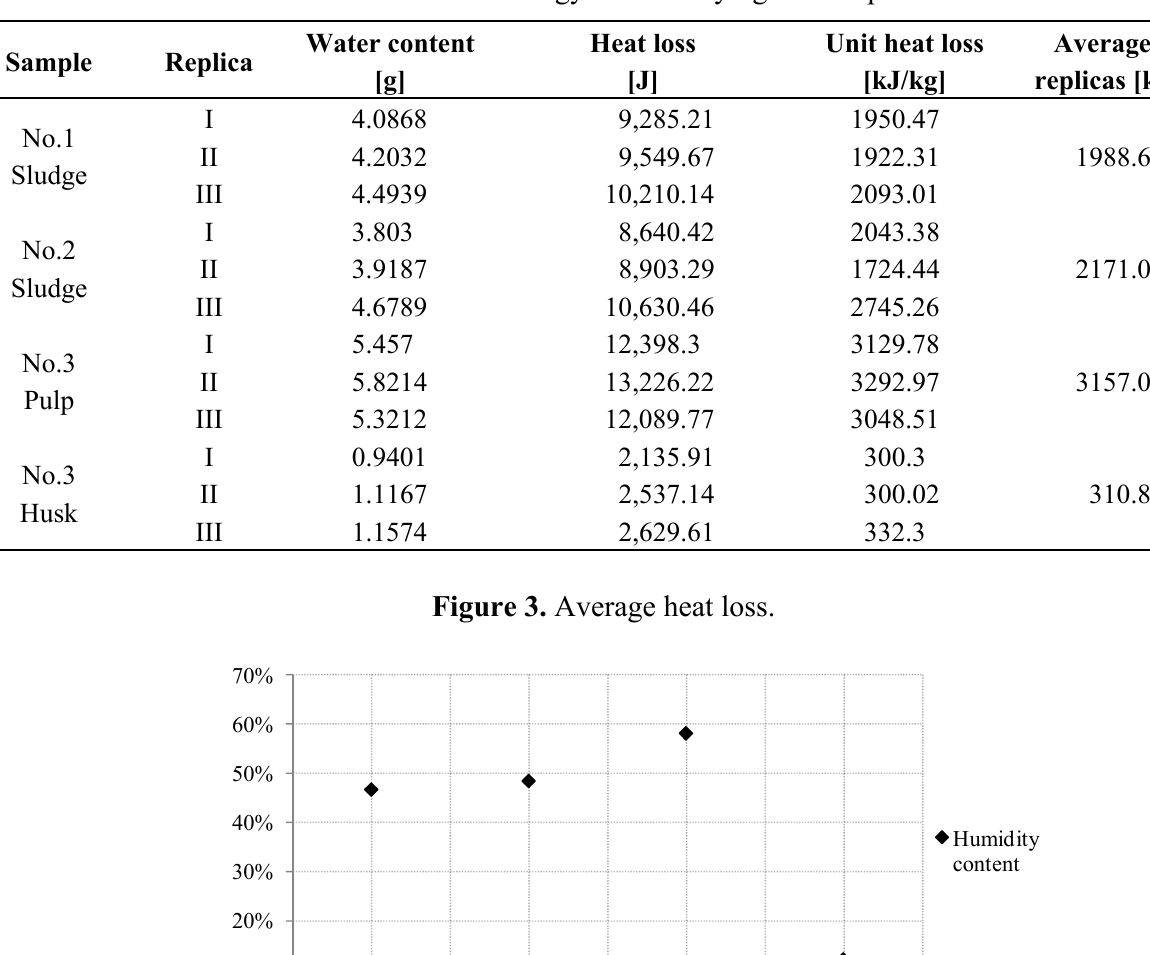
Table 2. Thermal energy loss for drying the samples.